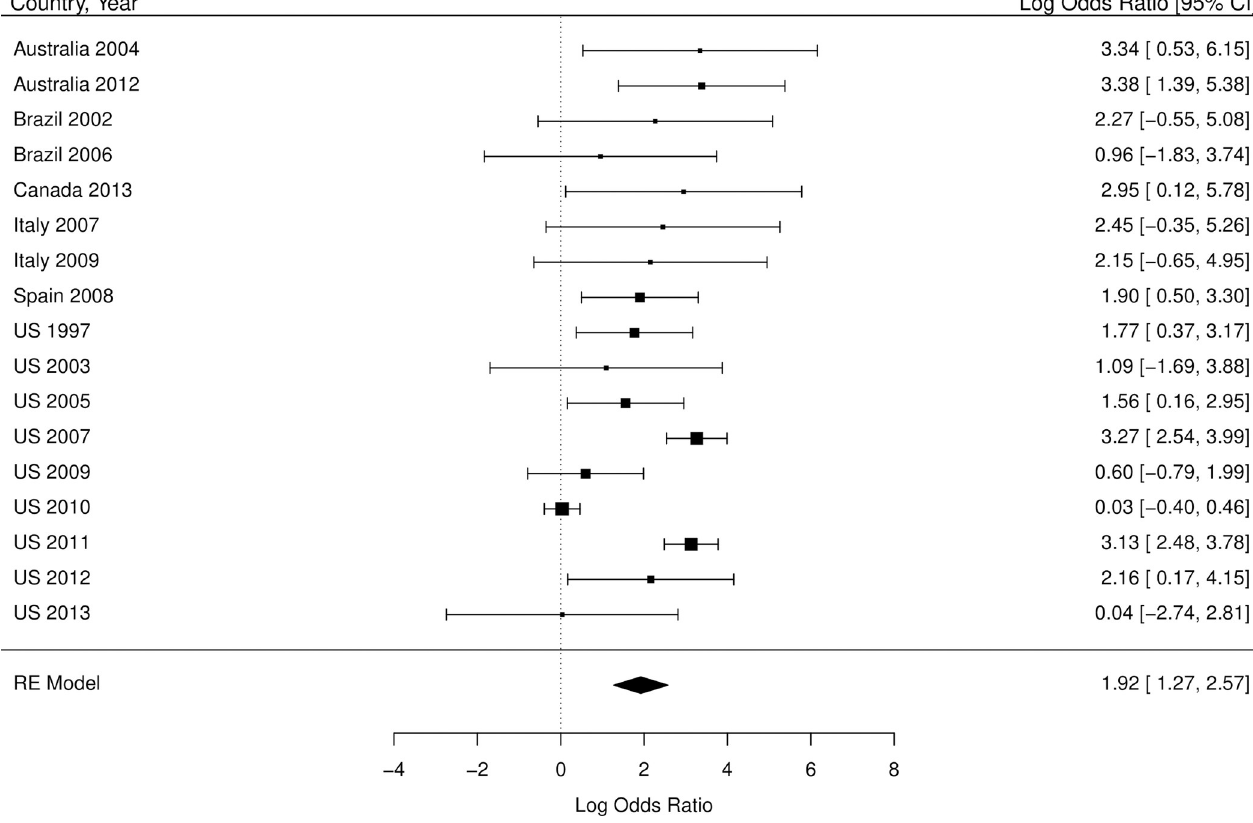
Fig 3. Forest plot of HIV prevalence in trans masculine individuals compared to all adults (age 15+). The scale on the x-axis is log odds ratio. The percentages indicate the weight of each country by year within the meta-analysis. The numbers in the right column are the log odds ratios including their confidence intervals. We converted these log odds ratios into odds ratios, as described in Table 3 .